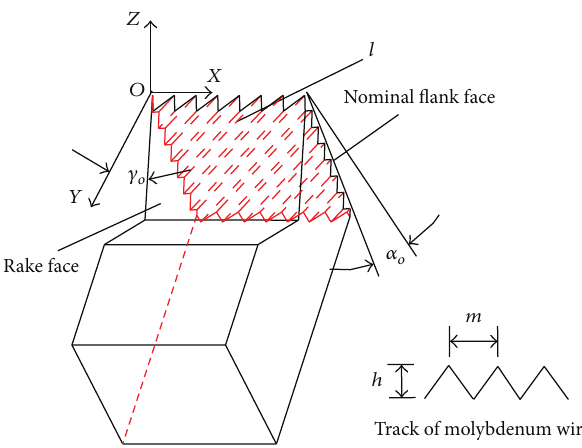
Figure 1: Schematic drawing of the multitooth tool.